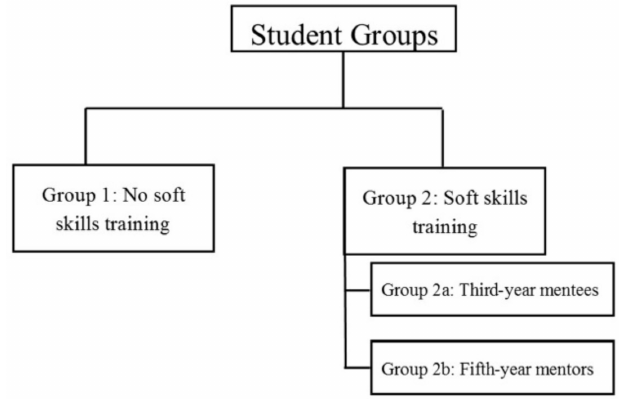
Figure 2. Student